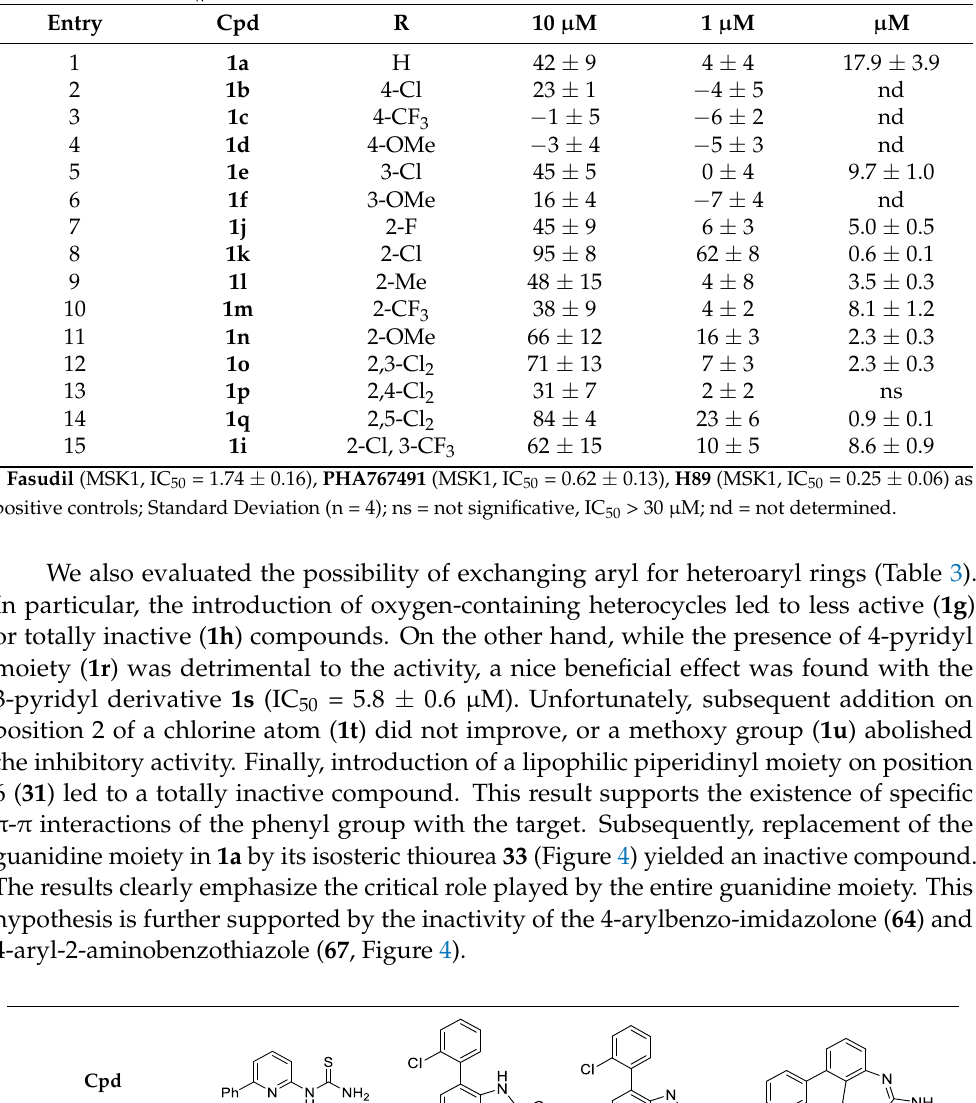
Table 3. Replacement of the phenyl group by heterocycles.